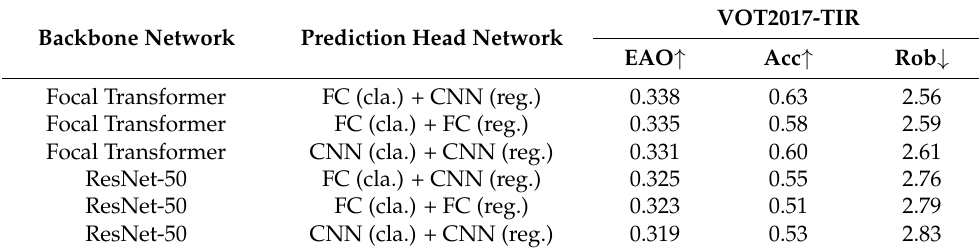
Table 2. The results of the ablation experiments in